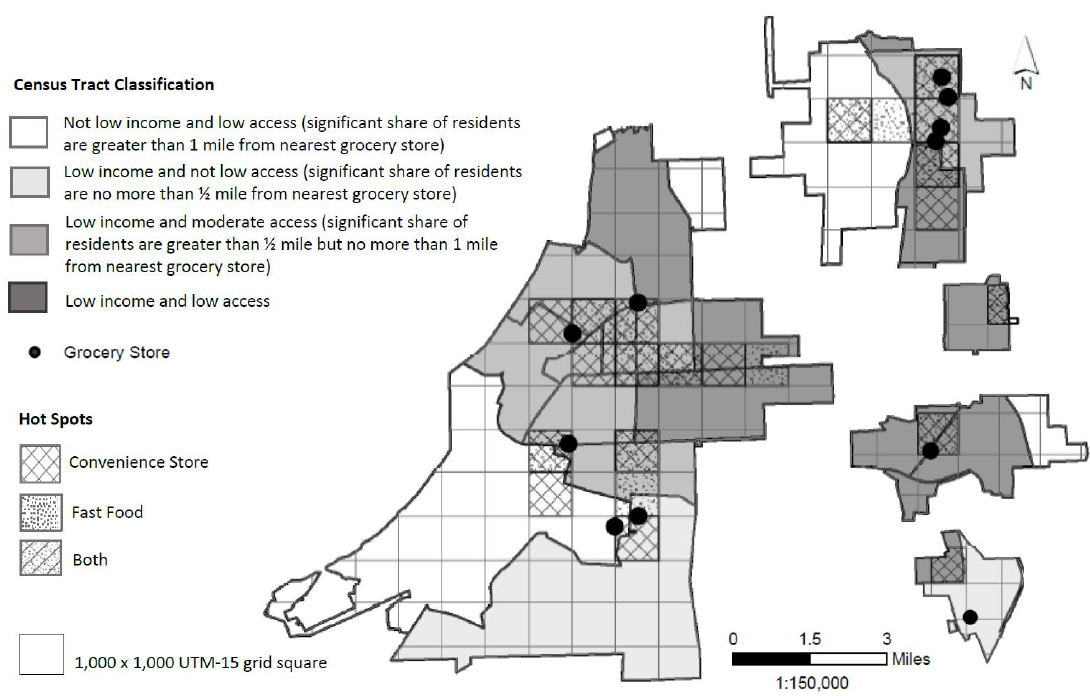
Figure 3. Spatial distribution of grocery stores in relation to census tract income and food access classification and hot spot type in the five rural Lower Mississippi Delta towns. Table 3. Characteristics of Delta Healthy Sprouts participants' residence by census tract class.